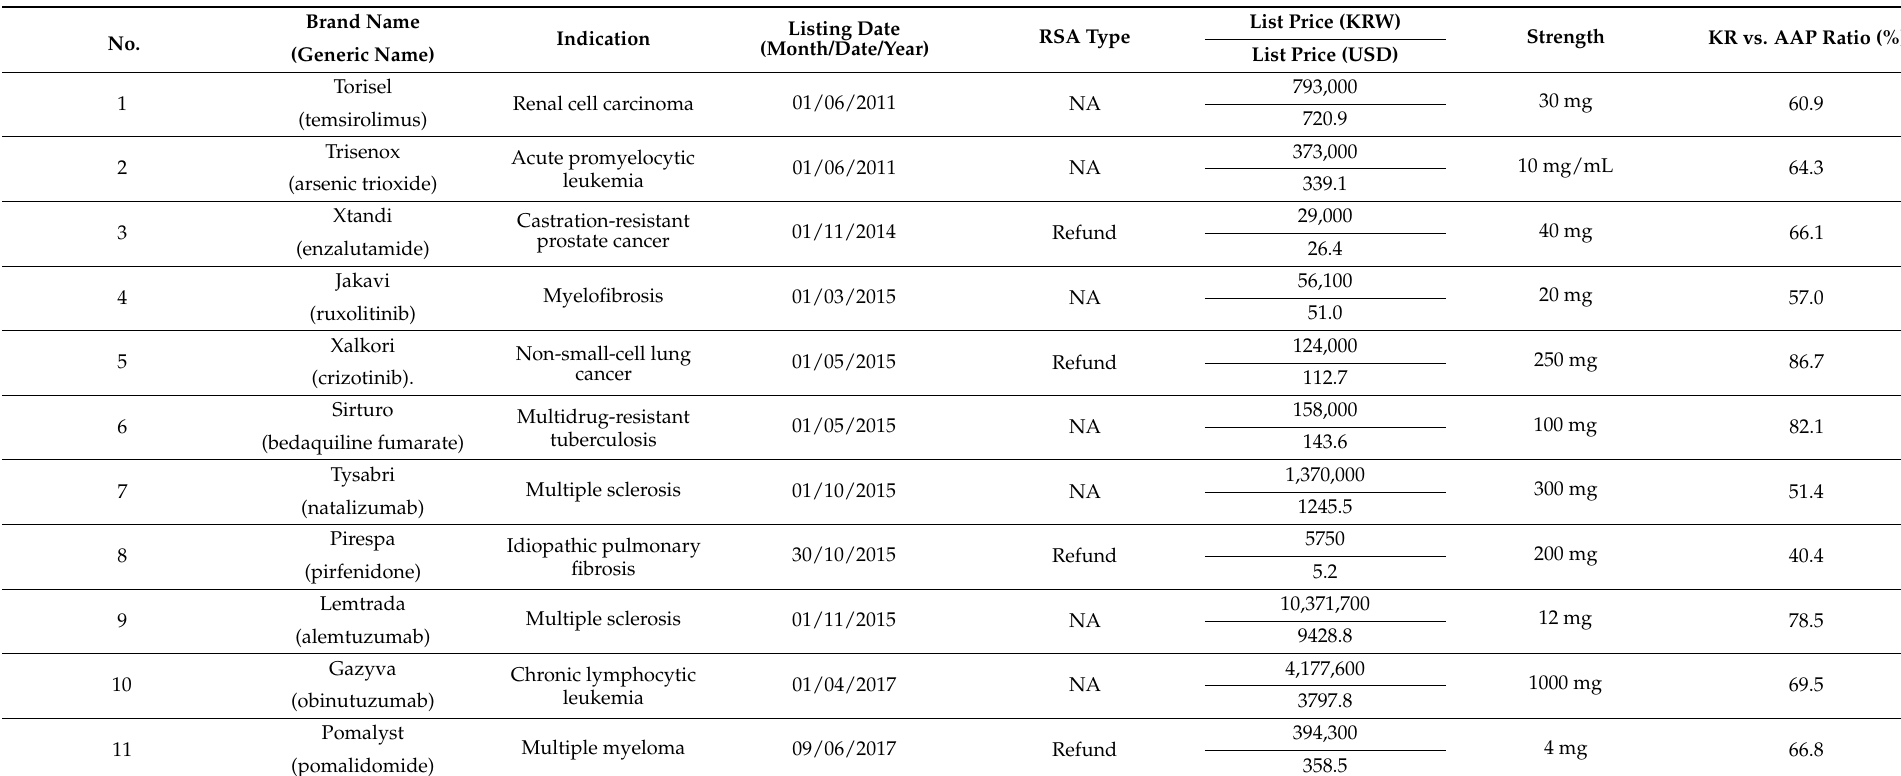
Table 4. New orphan drugs evaluated as pharmacoeconomic evaluation (PE) pathway in South Korea (listed during the period January 2007–March 2017).